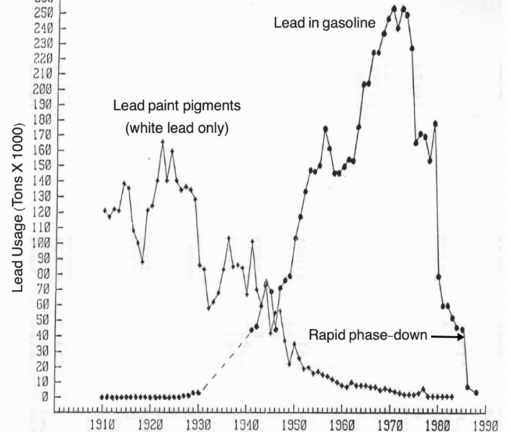
Figure 1. Graph comparing the U.S. annual quantities of Pb in paint and gasoline. In the late 1960s and early 1970s, appropriately sensitive analytical instruments became available to measure lead. Failure to include either one or another of the major sources is a disservice to public health. For example, Dr. Henderson’s concern about inhalation is not addressed when lead aerosols from the combustion of leaded petrol are ignored as a major source of